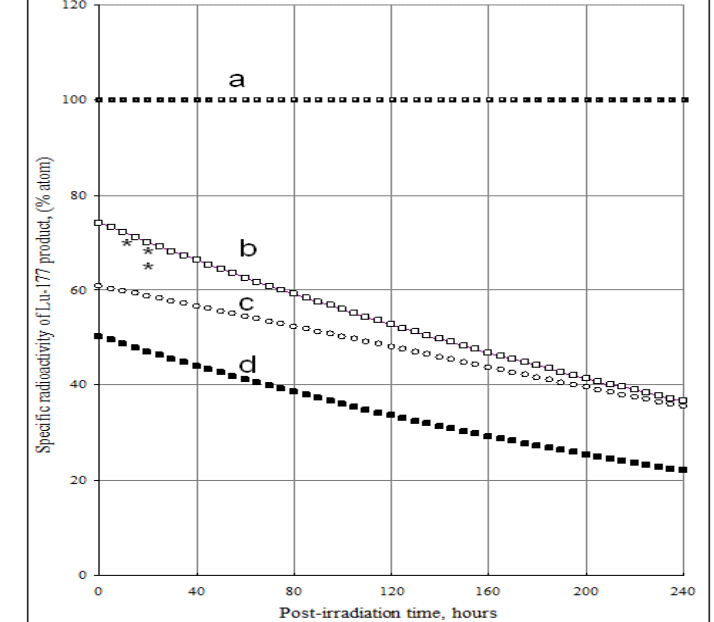
Figure 5. Specific radioactivity of 177 Lu in the 176 Yb target vs. post-irradiation time and content of 174 Yb and elemental Lu impurities. (Thermal neutron flux: 1213 105   scmn ; Irradiation time: 240 hours; Nuclear data extracted from literatures